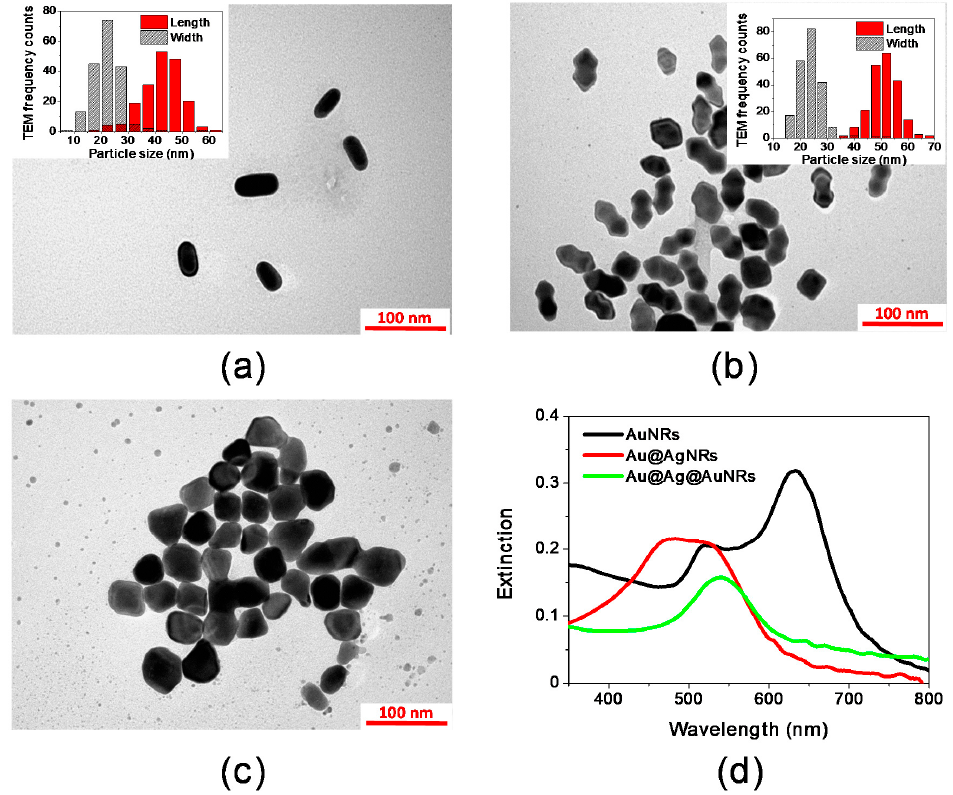
Figure 1. Morphological and spectroscopic characterization of AuNRs, Au@AgNRs and Au@Ag@AuNRs: ( a ) TEM image of AuNRs (scale bar 100 nm - Inset: size distribution); ( b ) TEM image